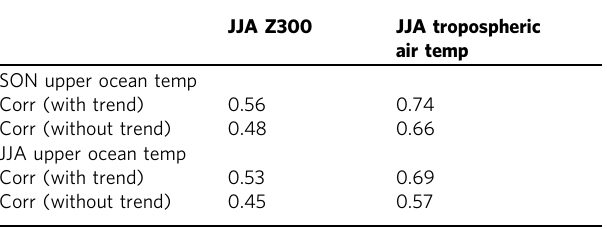
strong similarity with the linear trend of JJA Z300 fi eld in the past 40 years and therefore upper ocean warming appears to be driven Table 1 Correlations between the summer large-scale by the atmospheric circulation trend in JJA. Figure 1g, h also atmospheric circulation and upper ocean temperature in fall indicate that atmospheric warming in JJA in fl uences the ocean and summer. surface at zero lag, and in fl uences deeper layers later i.e., in SON. A more rigorous examination of the JJA atmosphere — SON ocean coupling is performed through maximum covariance analysis JJA (MCA) between the JJA atmospheric circulation and SON upper ocean temperature in the Arctic to investigate whether the links between atmosphere and ocean are tied to fundamental modes of variability with a spatially coherent structure (Supplementary Fig. 2). These collectively suggest that a portion of the SON upper ocean warming trend in the past decades results from JJA atmospheric circulation variability on an interdecadal time scale. Mechanisms linking JJA atmospheric changes with SON upper ocean temperature . What processes link JJA atmospheric